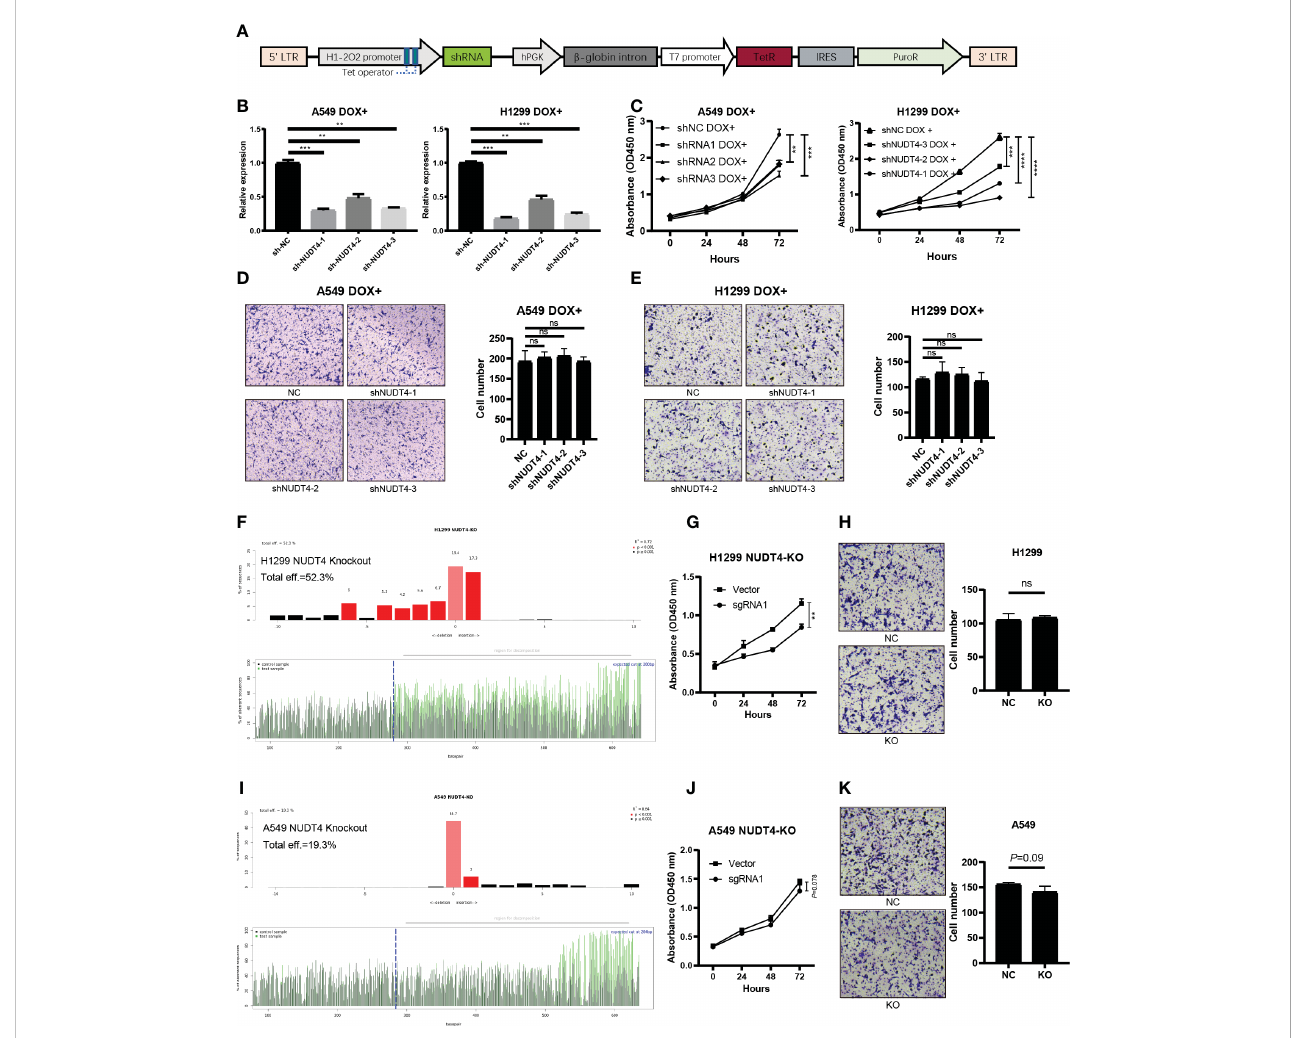
FIGURE 9 NUDT4 function validation in lung adenocarcinoma cell lines. (A) Sequence map of tet-on system shRNA plasmids. (B) NUDT4 knocking down ef fi ciency in cell lines. (C) CCK8 assay for detecting cell proliferation (n = 3 duplicates). (D) Transwell assay for detecting A549 cell migration (n = 3 duplicates). (E) Transwell assay for H1299 cell migration capability detection (n = 3 duplicates). (F) Knockout ef fi ciency of the NUDT4 in H1299 cell line. (G) CCK8 assay for detecting H1299 cell proliferation (n = 3 duplicates). (H) Transwell assay for detecting H1299 cell migration (n = 3 duplicates). (I) Knockout ef fi ciency of the NUDT4 in A549 cell line. (J) CCK8 assay for detecting A549 cell proliferation (n = 3 duplicates). (K) Transwell assay for detecting A549 cell migration (n = 3 duplicates). (** P < 0.01, *** P < 0.001, **** P < 0.0001, ns: Not statistically signi fi